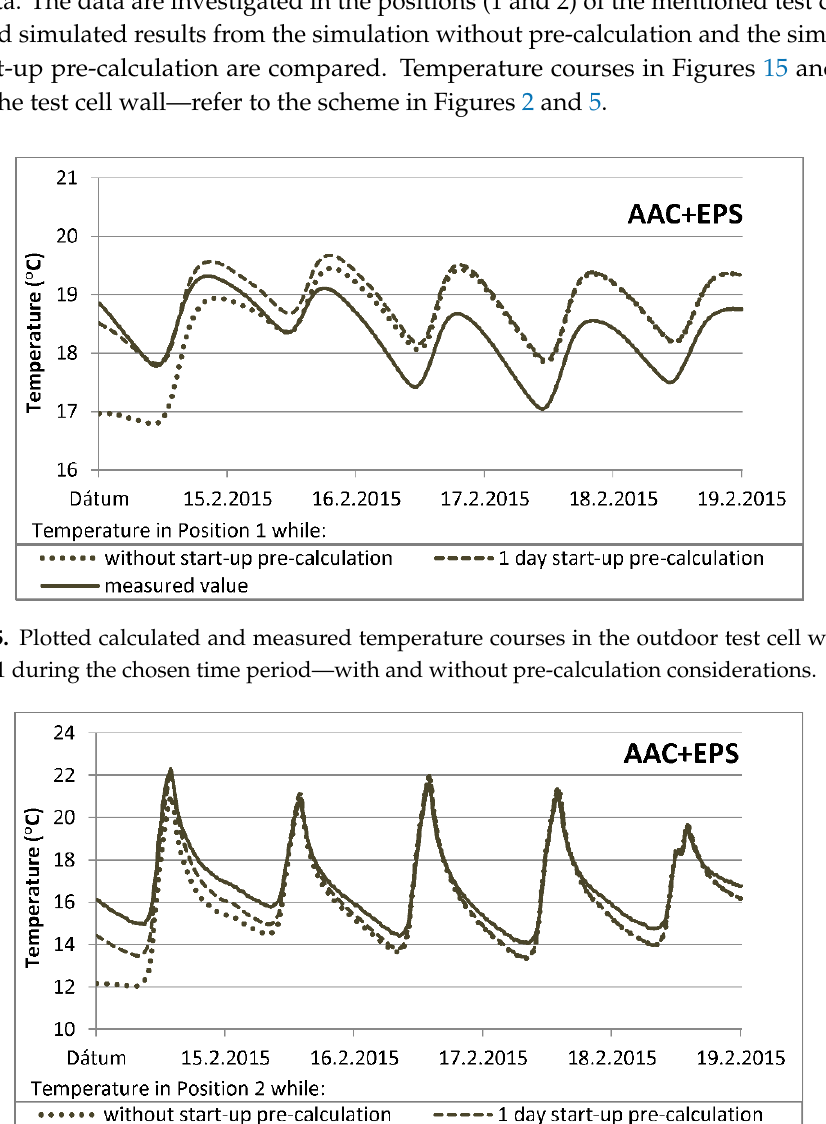
Figure 14. Temperature profile across the outdoor test cell wall (AAC + EPS) at time t = 0 h, t = 12 h